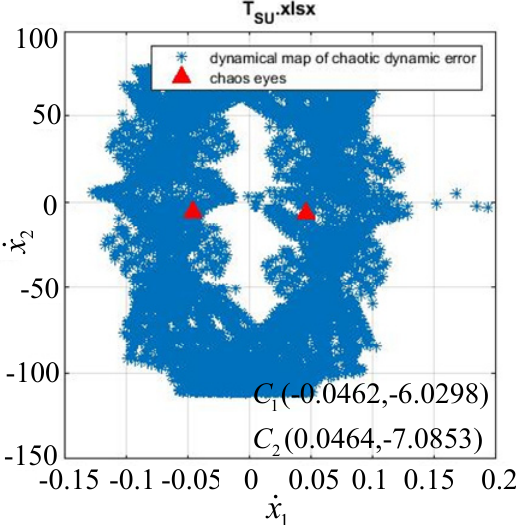
Figure 5. Chaotic states scatter diagram and corresponding chaos eyes.